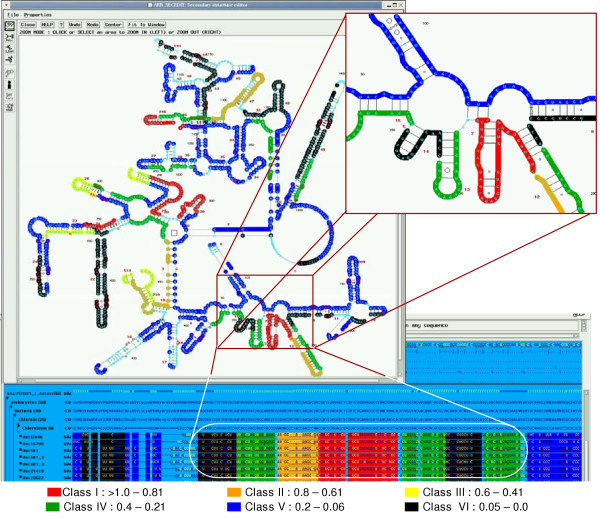
ARB Primary and secondary structure windows. ARB primary and secondary structure windows showing the distribution of relative fluorescence intensities of oligonucleotide probes targeting 16S rRNA structure of M. sedula [11]. The different background colors indicate brightness range of different classes (classes I through VI) with respect to the observed fluorescence intensities. Numbers displayed in black and lower case denotes the respective nucleotide positions and the numbers showing in red represent helix numbers in the model.